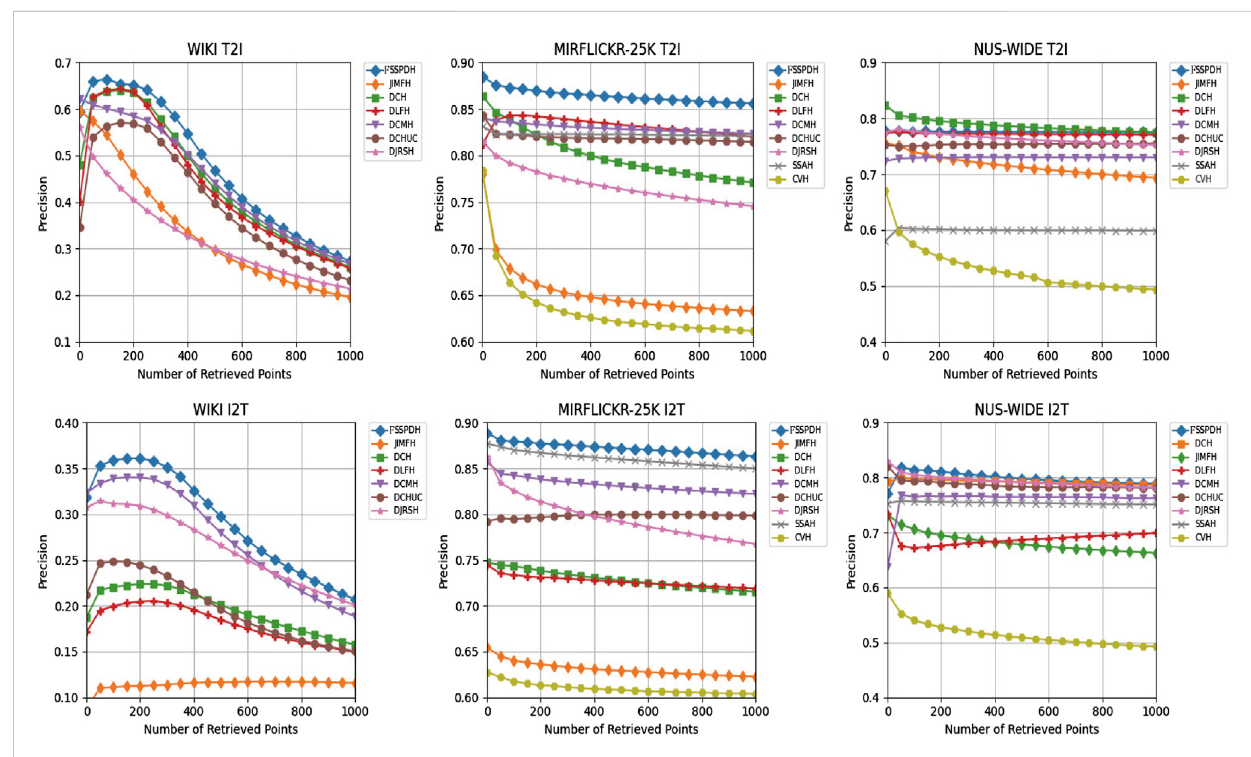
FIGURE 2 The TopN-precision curves of FSSPDH and its competitors on three datasets.